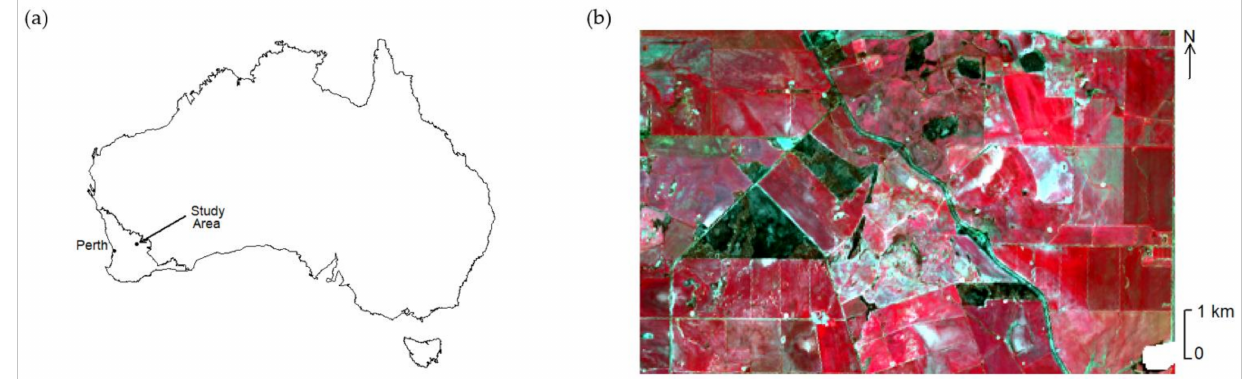
Figure 1. The study area: ( a ) 5000 ha located in the eastern grain belt of Western Australia; and ( b ) false-colour composite of the near-infrared, red and green bands from Landsat-8 OLI image acquired 29 August